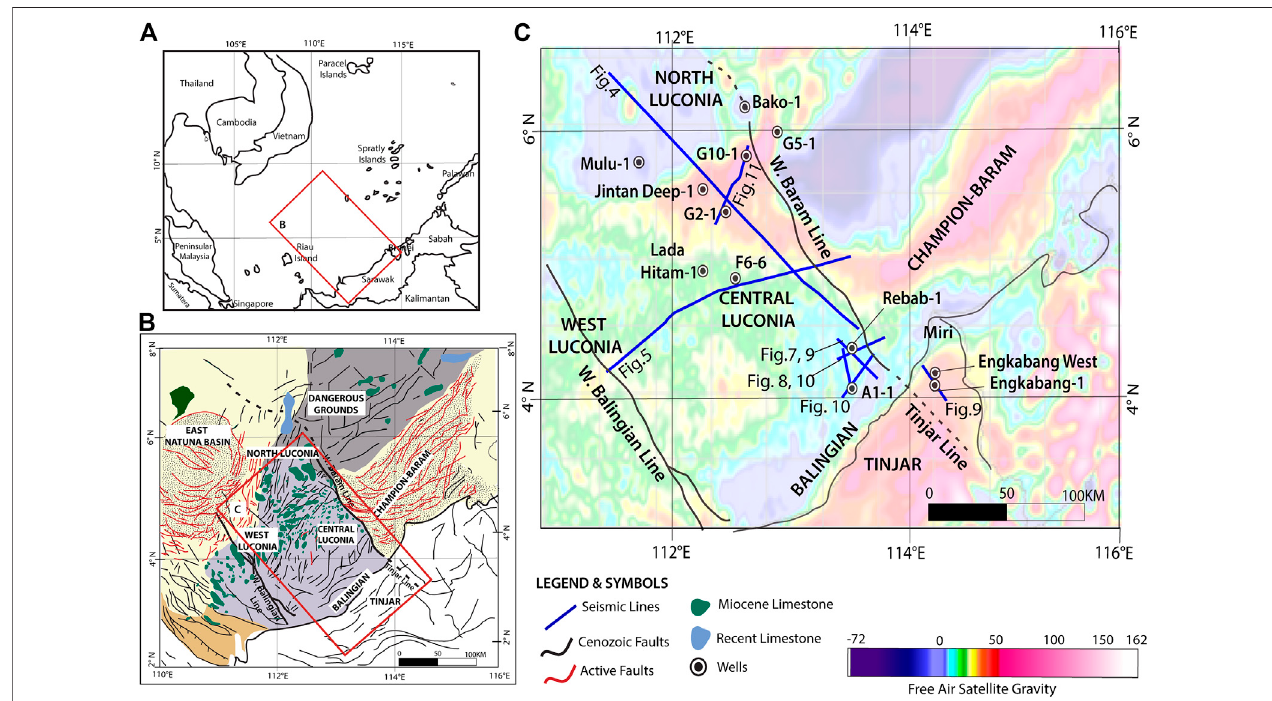
FIGURE 1 | (A) Location of the study area within the South East Asia setting with rectangle highlighting the map in (B) . (B) The geological provinces in offshore Sarawak, divided by major Cenozoic and recent faults. Middle to Upper Miocene and recent limestone build-ups are common in the Central-West-North Luconia Provinces. Map in (C) is highlighted in (B) . (C) 2D seismic lines presented in this study, with the well locations are shown, overlay with satellite gravity from Sandwell and Smith, (1997).